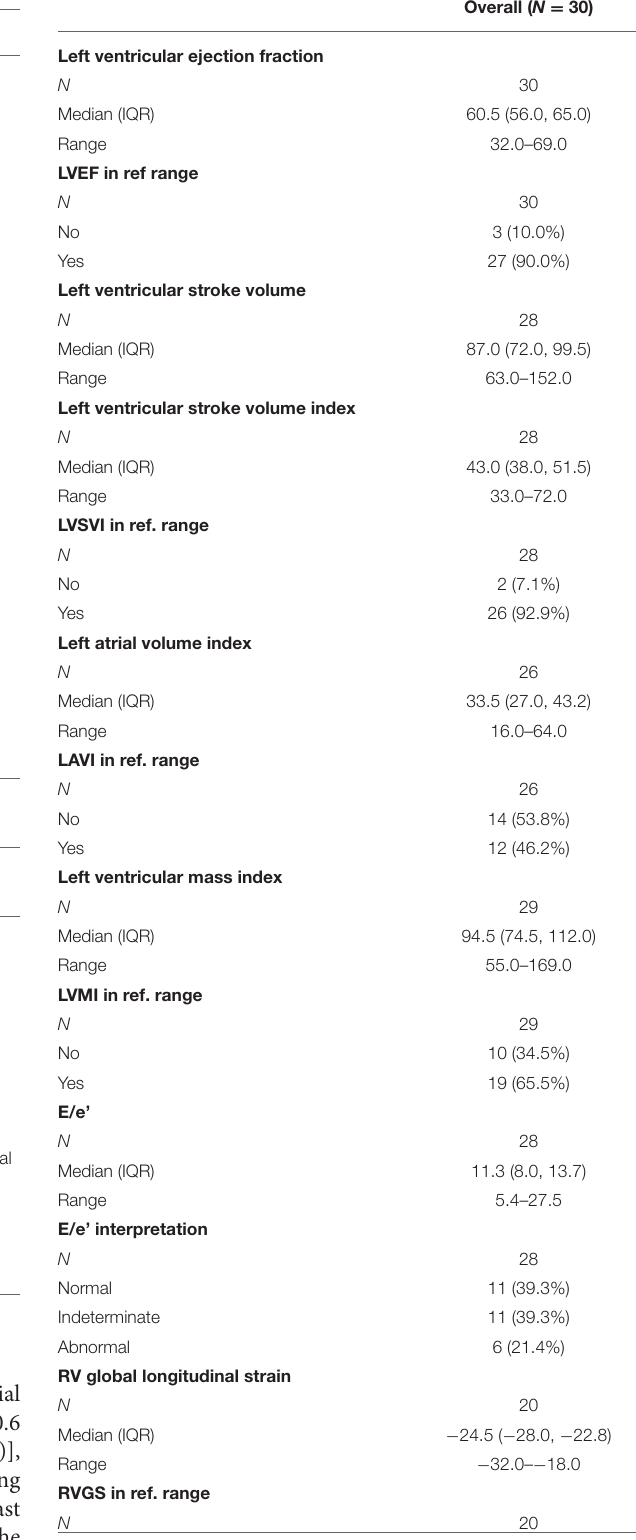
TABLE 4 | Demographic data for PH1 patients on RRT who underwent echocardiography.